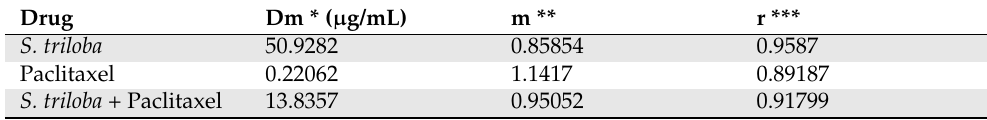
Table 4. Median effect dose for SKOV3 cells.